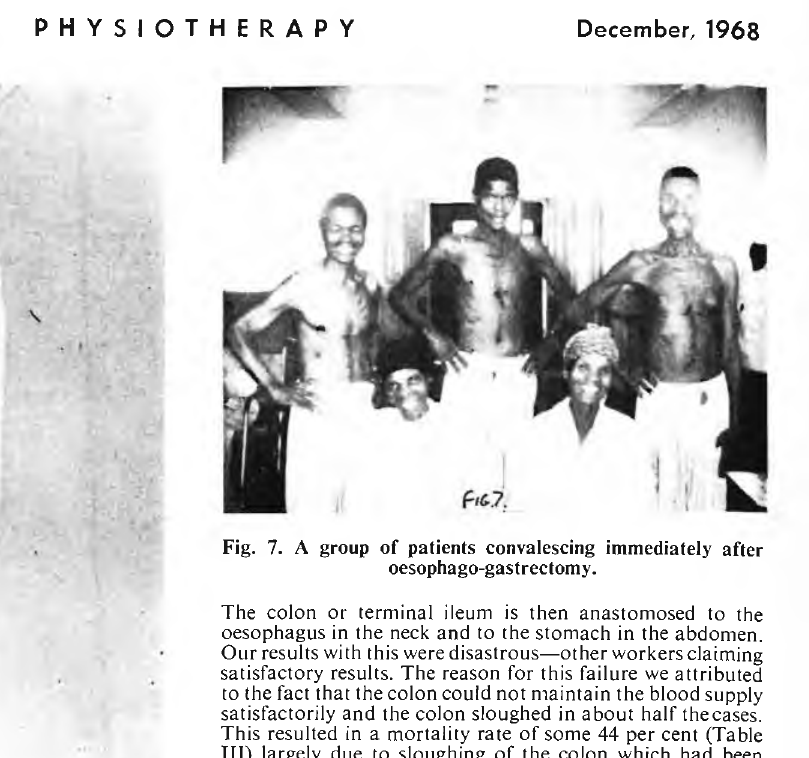
Fig. 7. A group of patients convalescing immediately after